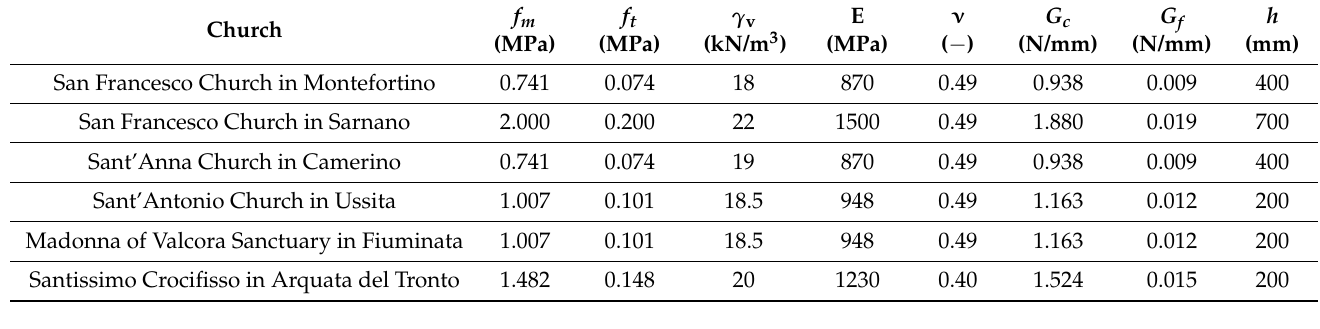
Figure 3. Numerical models of San Francesco Church in Montefortino ( a ), San Francesco Church in Sarnano ( b ), Sant’Anna Table 2. Mechanical characteristics of the main elements of the numerical models of the six churches analyzed. Church in Camerino ( c ), Sant’Antonio Church in Ussita ( d ), Madonna of Valcora Sanctuary in Fiuminata ( e ), Santissimo Crocifisso in Arquata del Tronto ( f ). Table 1. Main characteristics of the numerical models of the six churches analyzed.